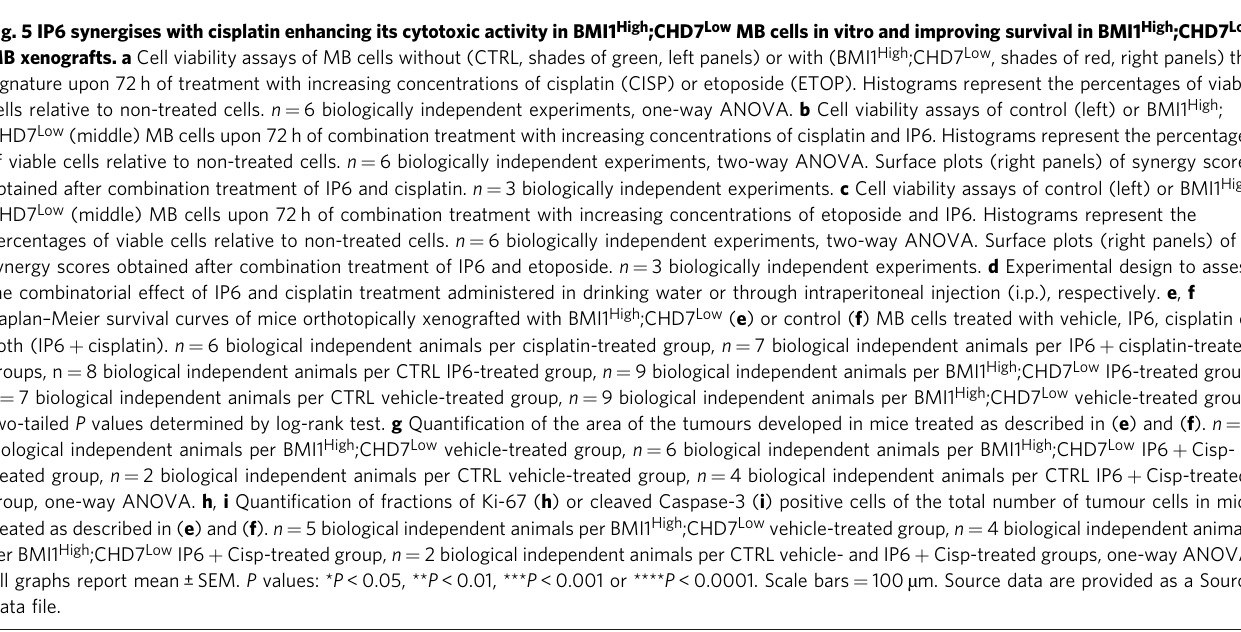
Fig. 5 IP6 synergises with cisplatin enhancing its cytotoxic activity in BMI1 High ;CHD7 Low MB cells in vitro and improving survival in BMI1 High ;CHD7 Low MB xenografts. a Cell viability assays of MB cells without (CTRL, shades of green, left panels) or with (BMI1 High ;CHD7 Low , shades of red, right panels) the signature upon 72 h of treatment with increasing concentrations of cisplatin (CISP) or etoposide (ETOP). Histograms represent the percentages of viable cells relative to non-treated cells. n = 6 biologically independent experiments, one-way ANOVA. b Cell viability assays of control (left) or BMI1 High ; CHD7 Low (middle) MB cells upon 72 h of combination treatment with increasing concentrations of cisplatin and IP6. Histograms represent the percentages of viable cells relative to non-treated cells. n = 6 biologically independent experiments, two-way ANOVA. Surface plots (right panels) of synergy scores obtained after combination treatment of IP6 and cisplatin. n = 3 biologically independent experiments. c Cell viability assays of control (left) or BMI1 High ; CHD7 Low (middle) MB cells upon 72 h of combination treatment with increasing concentrations of etoposide and IP6. Histograms represent the percentages of viable cells relative to non-treated cells. n = 6 biologically independent experiments, two-way ANOVA. Surface plots (right panels) of synergy scores obtained after combination treatment of IP6 and etoposide. n = 3 biologically independent experiments. d Experimental design to assess the combinatorial effect of IP6 and cisplatin treatment administered in drinking water or through intraperitoneal injection (i.p.), respectively. e , f Kaplan – Meier survival curves of mice orthotopically xenografted with BMI1 High ;CHD7 Low ( e ) or control ( f ) MB cells treated with vehicle, IP6, cisplatin or both (IP6 + cisplatin). n = 6 biological independent animals per cisplatin-treated group, n = 7 biological independent animals per IP6 + cisplatin-treated groups, n = 8 biological independent animals per CTRL IP6-treated group, n = 9 biological independent animals per BMI1 High ;CHD7 Low IP6-treated group, n = 7 biological independent animals per CTRL vehicle-treated group, n = 9 biological independent animals per BMI1 High ;CHD7 Low vehicle-treated group, two-tailed P values determined by log-rank test. g Quanti fi cation of the area of the tumours developed in mice treated as described in ( e ) and ( f ). n = 8 biological independent animals per BMI1 High ;CHD7 Low vehicle-treated group, n = 6 biological independent animals per BMI1 High ;CHD7 Low IP6 + Cisp- treated group, n = 2 biological independent animals per CTRL vehicle-treated group, n = 4 biological independent animals per CTRL IP6 + Cisp-treated group, one-way ANOVA. h , i Quanti fi cation of fractions of Ki-67 ( h ) or cleaved Caspase-3 ( i ) positive cells of the total number of tumour cells in mice treated as described in ( e ) and ( f ). n = 5 biological independent animals per BMI1 High ;CHD7 Low vehicle-treated group, n = 4 biological independent animals per BMI1 High ;CHD7 Low IP6 + Cisp-treated group, n = 2 biological independent animals per CTRL vehicle- and IP6 + Cisp-treated groups, one-way ANOVA. All graphs report mean ± SEM. P values: * P < 0.05, ** P < 0.01, *** P < 0.001 or **** P < 0.0001. Scale bars = 100 µ m. Source data are provided as a Source Data fi